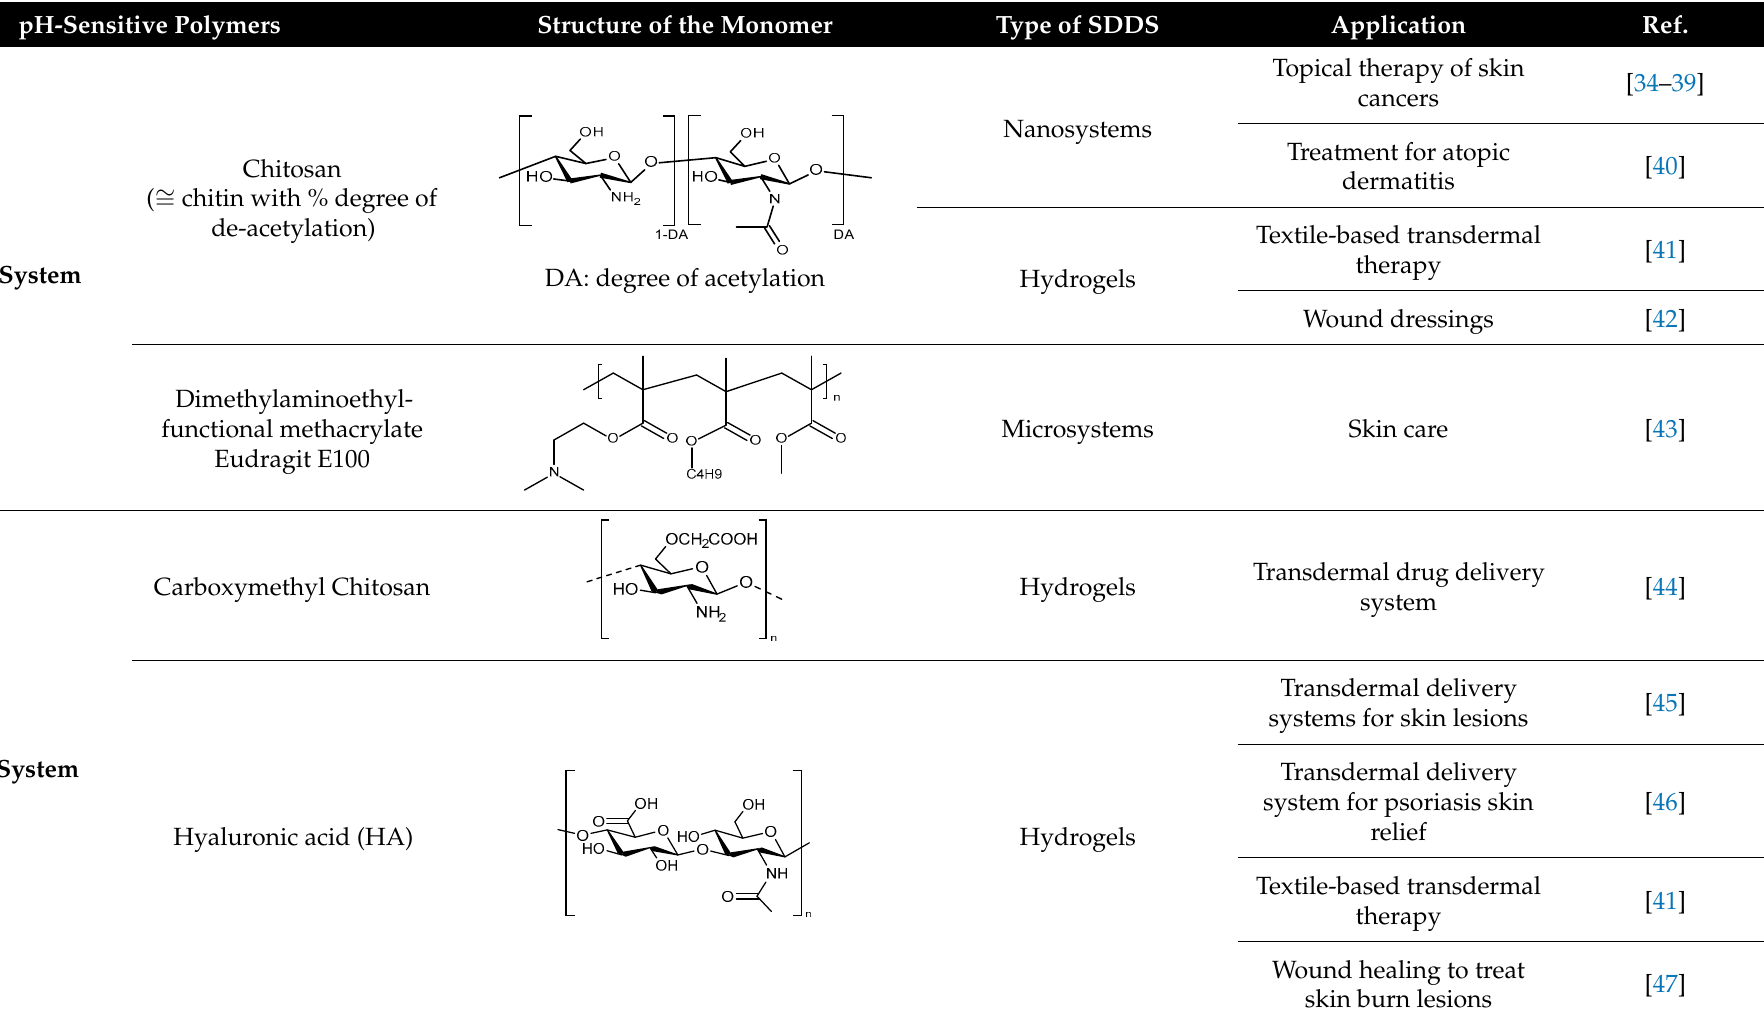
Table 1. Structure of pH-responsive polymers used to design smart drug delivery systems for skin application. pH-Sensitive Polymers